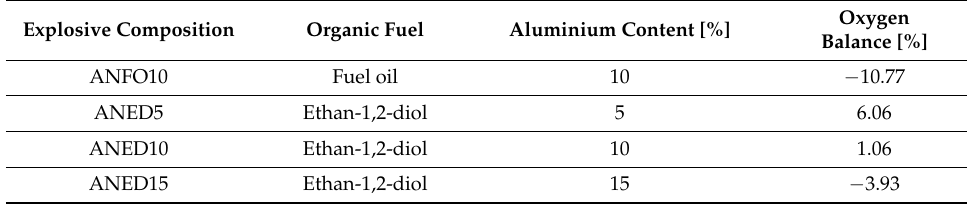
Figure 1. SEM photo of Al f powder. Table 4. Oxygen balances of aluminised